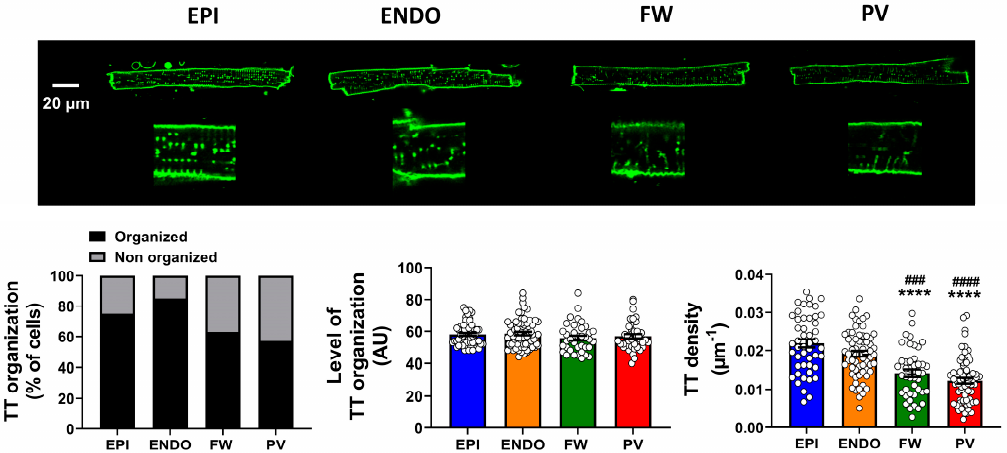
Figure 2. T-tubule characteristics in left atria from sheep. Top panel shows representative images of atrial myocytes stained with di-8 ANNEPS and visualized under confocal microscopy from four regions, epicardium (EPI), endocardium (ENDO), free wall (FW) and pulmonary vein (PV). Images of ×2.8 magnification are shown (below). Lower panel is percentage of cells showing an organized t-tubule (TT) network (black bars) and no organized TT (grey bars), Mean ± SEM TT regularity in cells with organized TT network and associated TT density in each group of cells. Data for TT organization and regularity analysis are from EPI = 81; ENDO = 79; FW = 59 and PV = 76. Data for TT density analysis are from EPI = 48; ENDO = 63; FW = 43 and PV = 65. **** p < 0.0001 compare to EPI and ## p < 0.01, #### p < 0.0001 compare to ENDO.